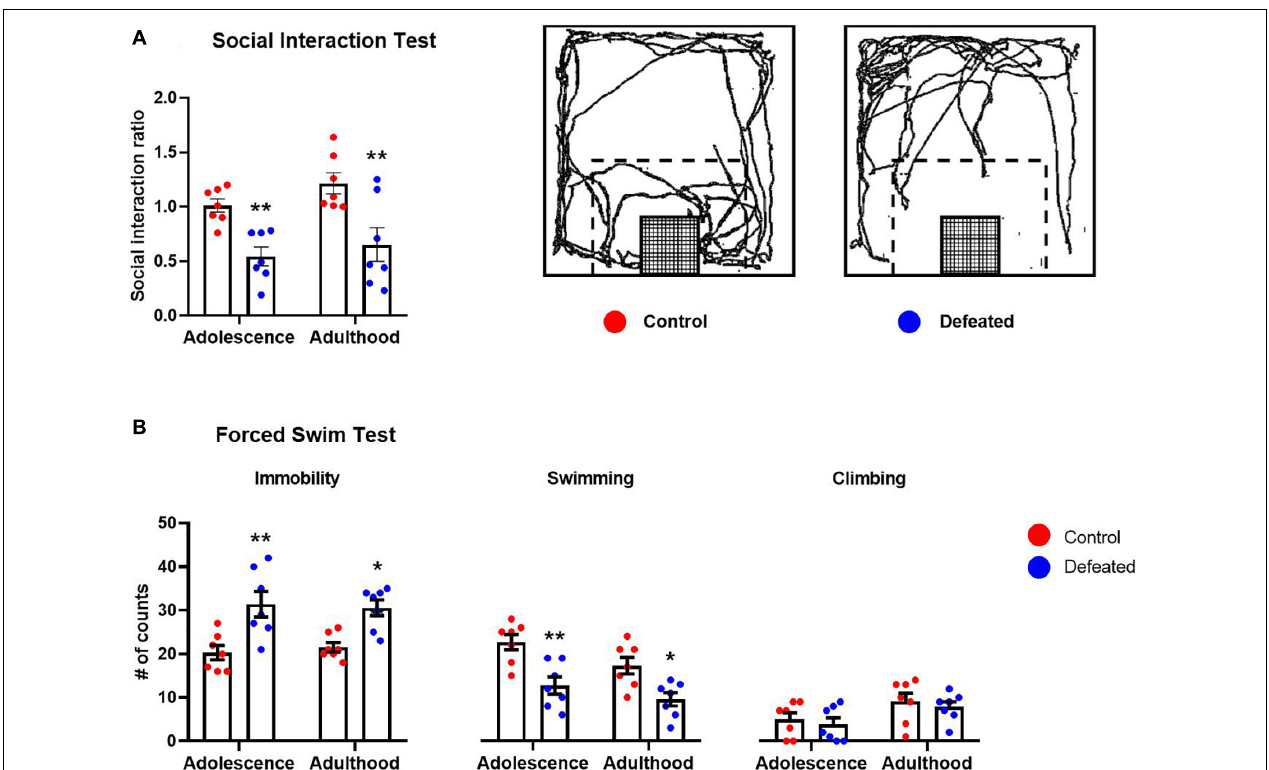
FIGURE 1 | Effects of the CSD in the (A) social interaction test and (B) forced swimming test, in both adolescence and adulthood. Data are presented as the mean ± SEM of the social interaction ratio or the number of counts of the immobility, swimming, and climbing behaviors. Schematic representation of the social interaction arena illustrating the location and size of the interaction zone (dotted line) with respect to the wire-mesh enclosure (grid) in which a social target is placed. Representative track of the travel done by a control or defeated mouse when the social target was present (A) . Two-way ANOVA, post hoc Sidak’s test * p < 0.05, ** p < 0.01, n =